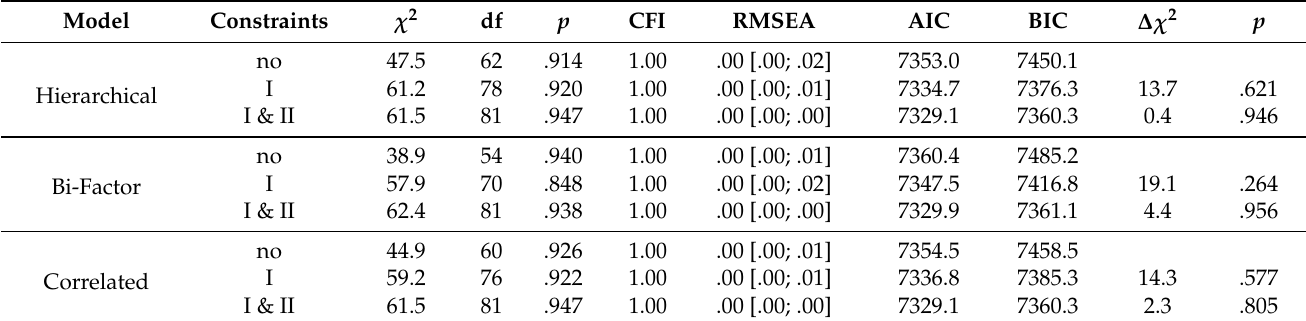
Table 3. Model fit for measurement models of fluid intelligence measures.